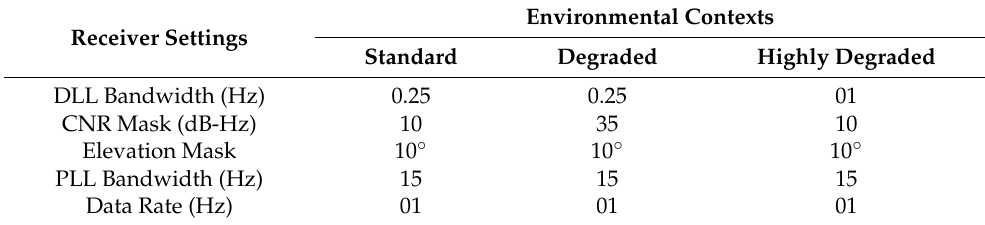
Table 5. The GNSS receiver level settings in three different operating